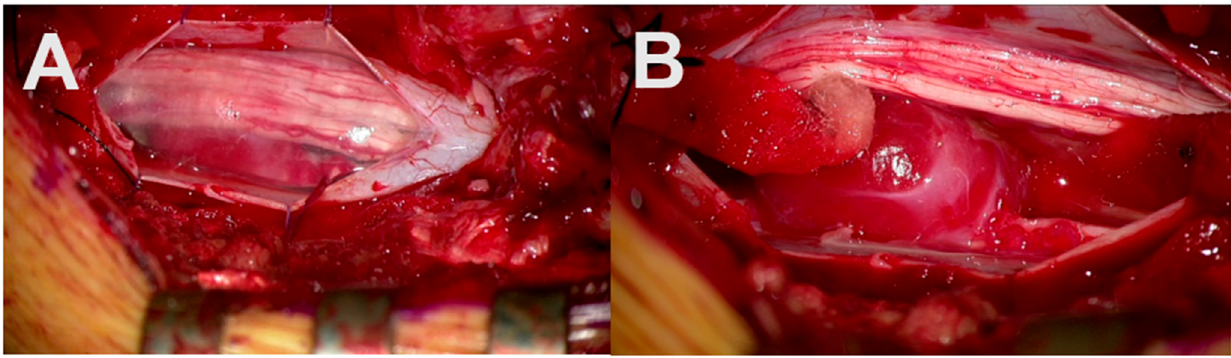
Figure 5. Evacuation of an intracerebral hemorrhage with the assistance of tubes. Intraoperative visualization of the hemorrhage during Aeos surgery.